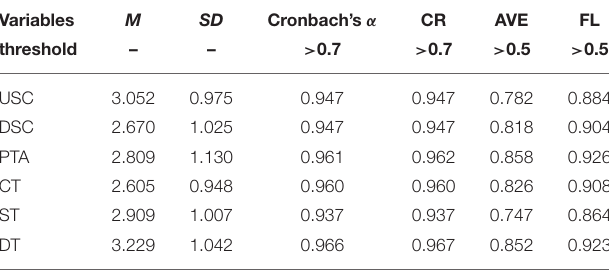
TABLE 2 | Reliability and validity analysis.